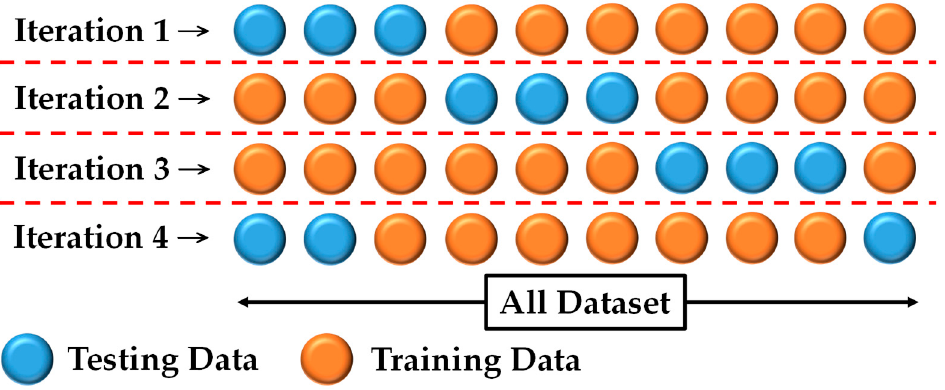
Figure 4. The K-fold cross-validation of this work.